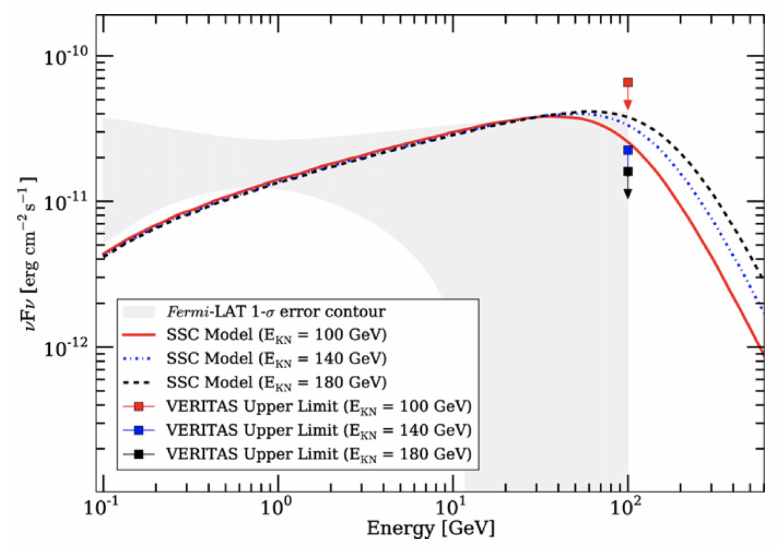
Figure 3. Joint LAT-VERITAS SED of GRB 130427A. The VERITAS upper limits at the observing time 71 ks to 75 ks were calculated assuming an SSC model with breaks at 100, 140, and 180 GeV (solid, dot-dashed, and dashed lines, respectively). The gray shaded region shows the 1 σ range of PL models compatible with the LAT data after temporal extrapolation from 10ks to 70ks. From [42]. H.E.S.S. has followed-up 49 GRBs between 2008 and 2018 (this number already ignores 19 follow-ups performed in bad weather conditions or with issues in the data